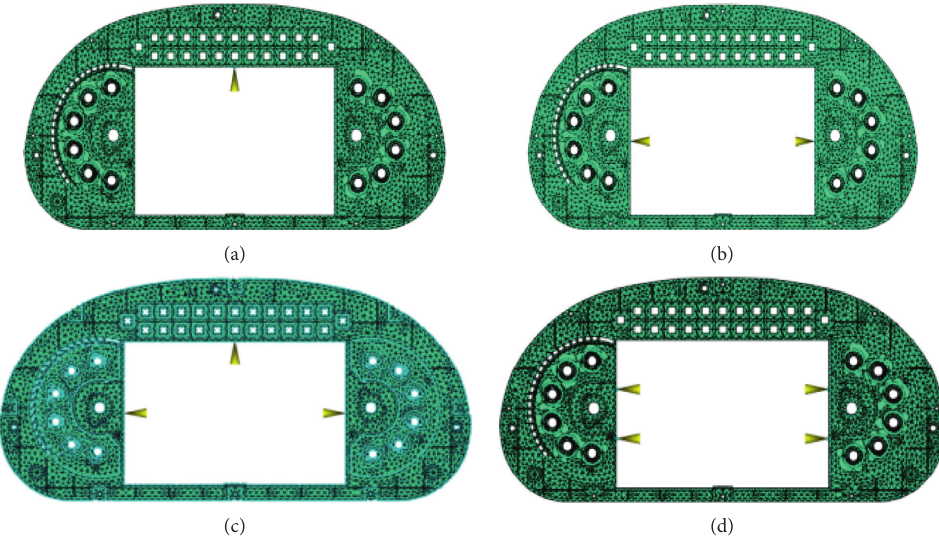
Figure 3: Configurations of four gate locations.